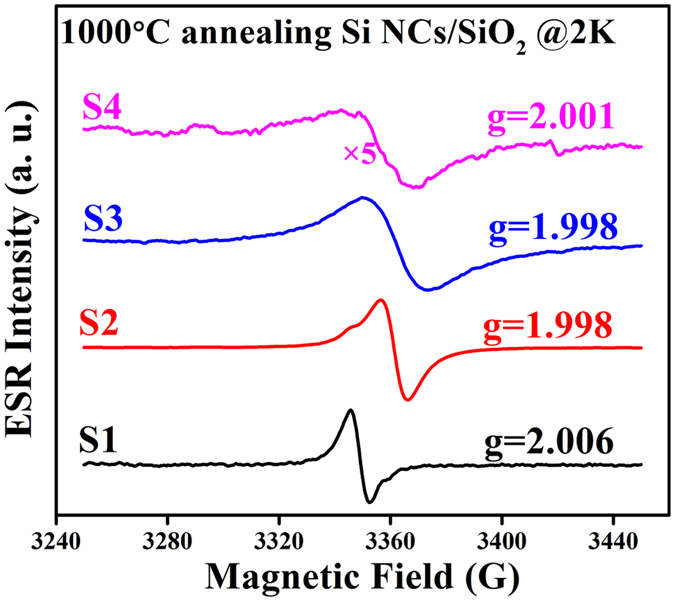
Low temperature ESR spectra after 1000 °C annealing.The X-band ESR spectra of Si NCs/SiO2 multilayers after 1000 °C annealing are detected at 2 K.